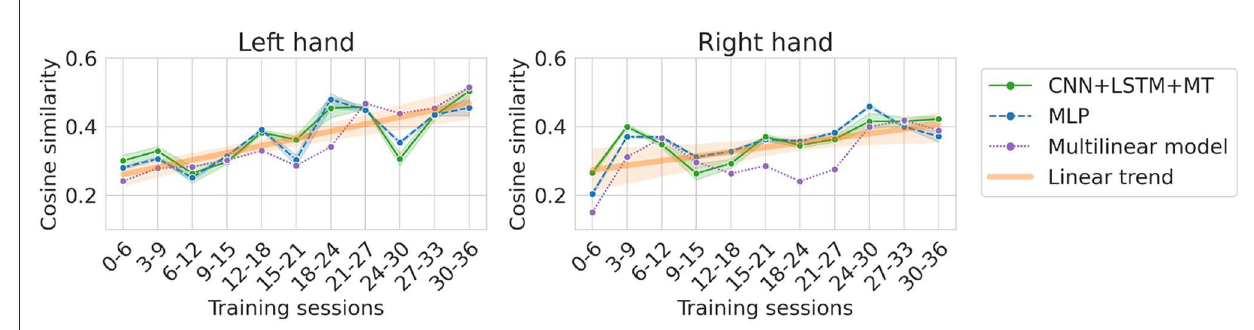
FIGURE8 Cosine similarity for dataset translation, i.e., different training datasets (always 6 sessions for training and following 6 sessions for testing) translated over the dataset. The orange line indicates a linear trend line fitted to the models’ average (left, right) .